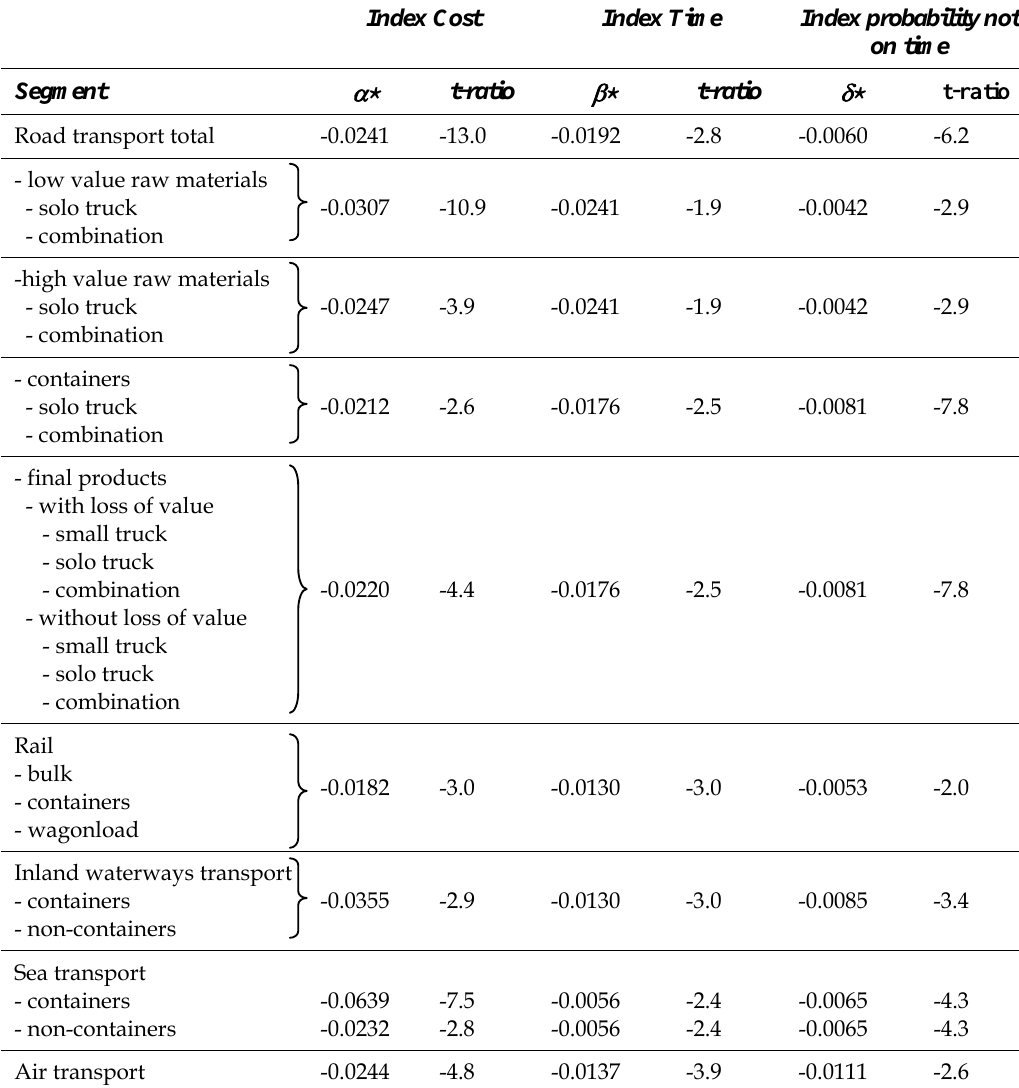
Table 2. Estimation results from 2003/2004 Dutch freight value of time survey